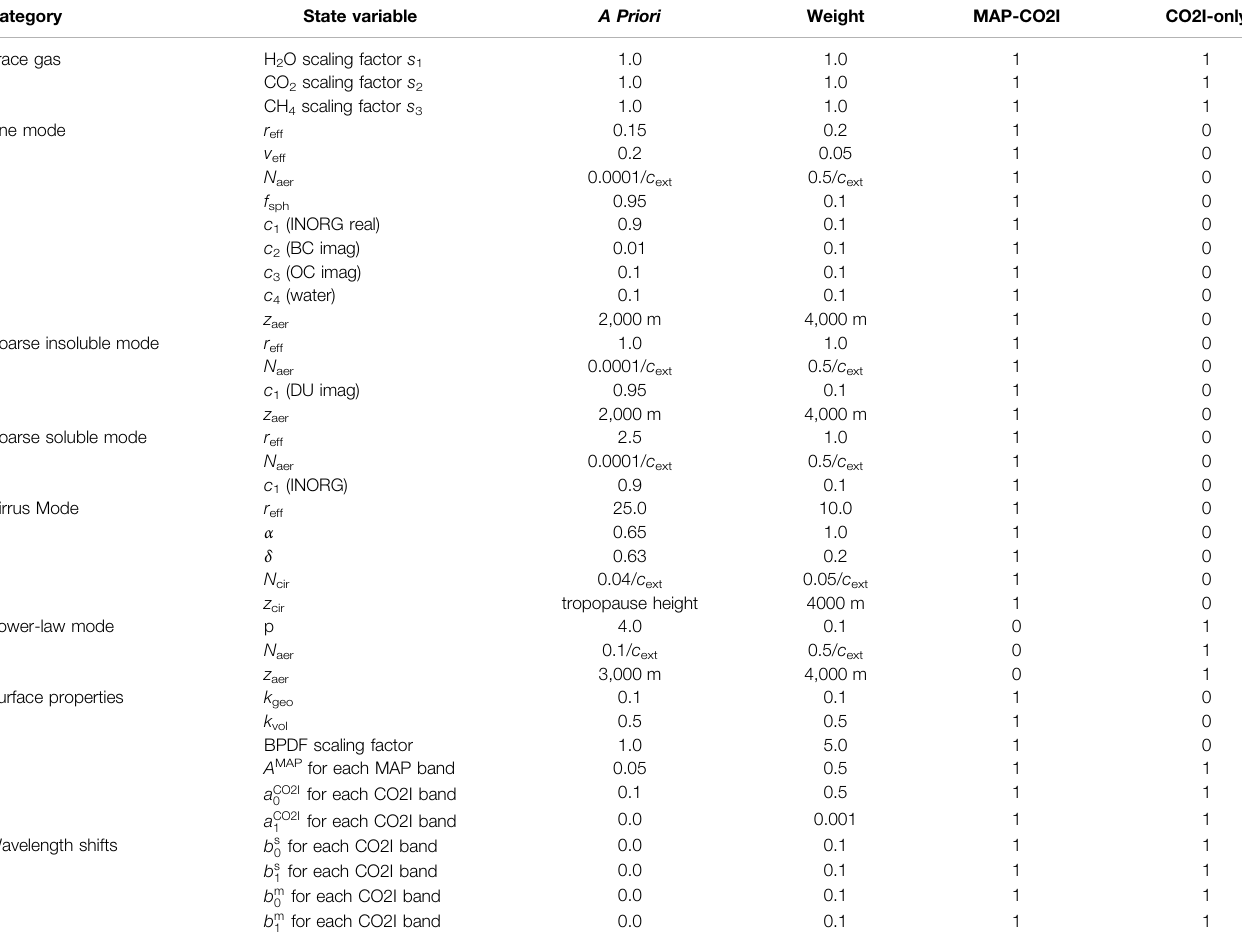
TABLE 4 | State variables in the full-physics retrieval, where c ext is the cross-section extinction coef fi cient. Category